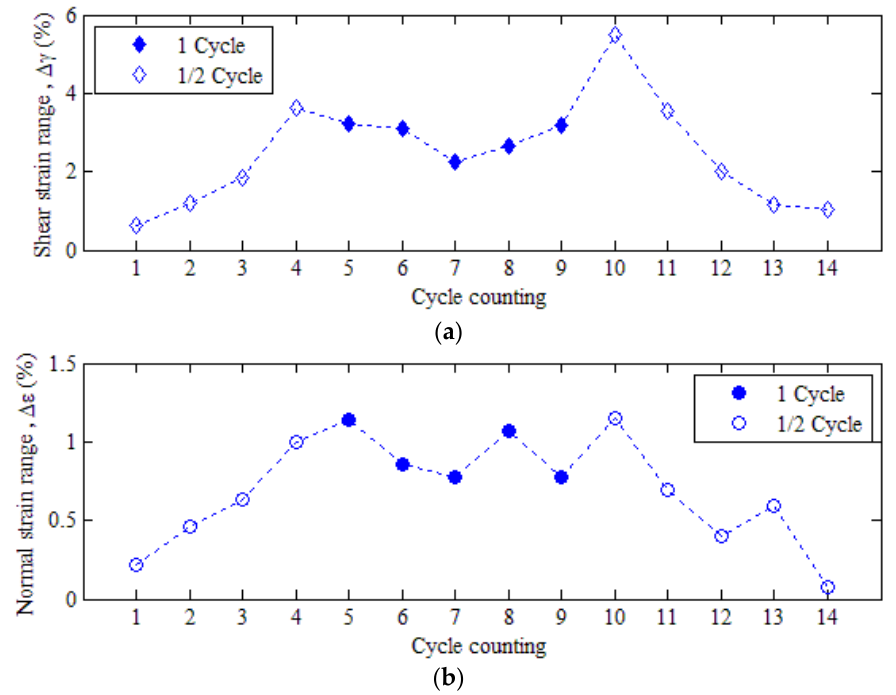
Figure 14. The load spectra of variable amplitude fatigue: ( a ) shear strain range; ( b ) normal strain range.